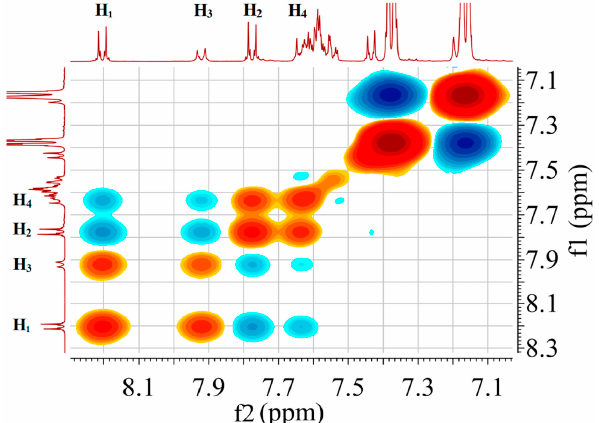
Figure 2. 2D ( 1 H- 1 H) ROESY spectrum in the aromatic region showing interaction between Ph 3 PAuSC 6 H 4 NO 2 and CH 3 C 6 H 4 SSC 6 H 4 NO 2 (DMSO- d 6 ). See Scheme 2 for assignment of aromatic protons labeled H 1 , H 2 , H 3 , and H 4 . (The intense peaks at 7.16 and 7.37 ppm are due to the excess CH 3 C 6 H 4 S-SC 6 H 4 CH 3 ; see Experimental